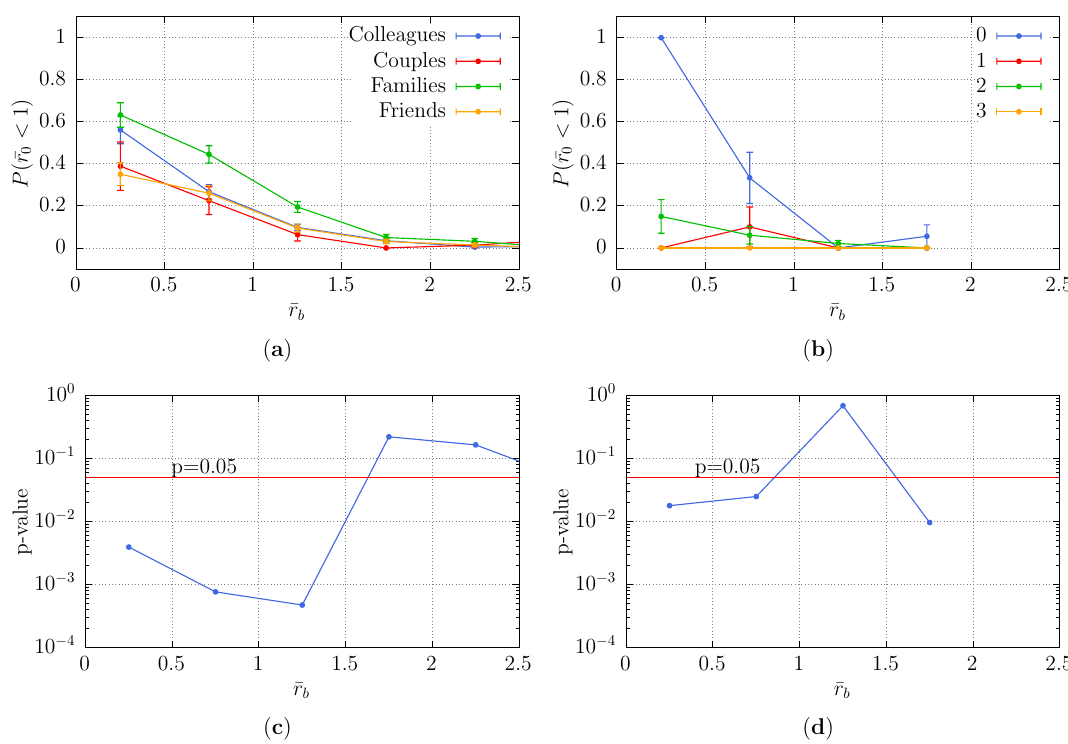
Figure 6. Probability that the distance ¯ r 0 is smaller than 1 for ( a ) for various social relations and ( b ) intensities 2 p of interaction of the dyad. Pearson’s χ -values for the hypothesis of independence of the frequencies of samples verifying ¯ r 0 < 1 for ( c ) for various social relations and ( d ) intensities of interaction (of the